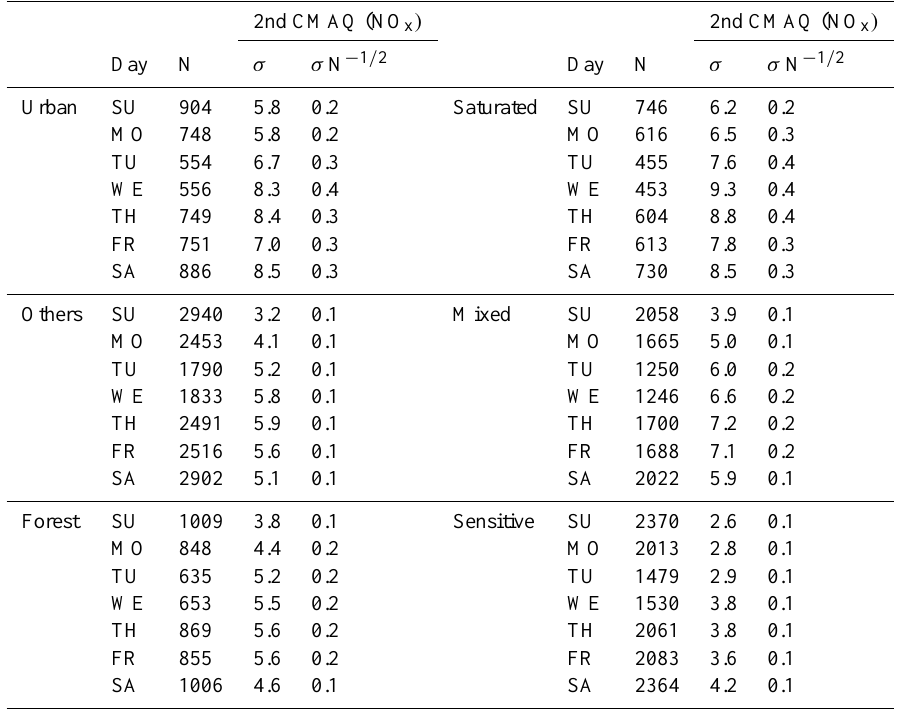
Table 5. The number of data (NO x concentration), the standard deviation, and the standard error of the mean (SEM) of CMAQ simulations with GOME-2 adjusted emissions for NO x measurement sites over the AVHRR-derived geographical regions and GOME-2-derived chemical